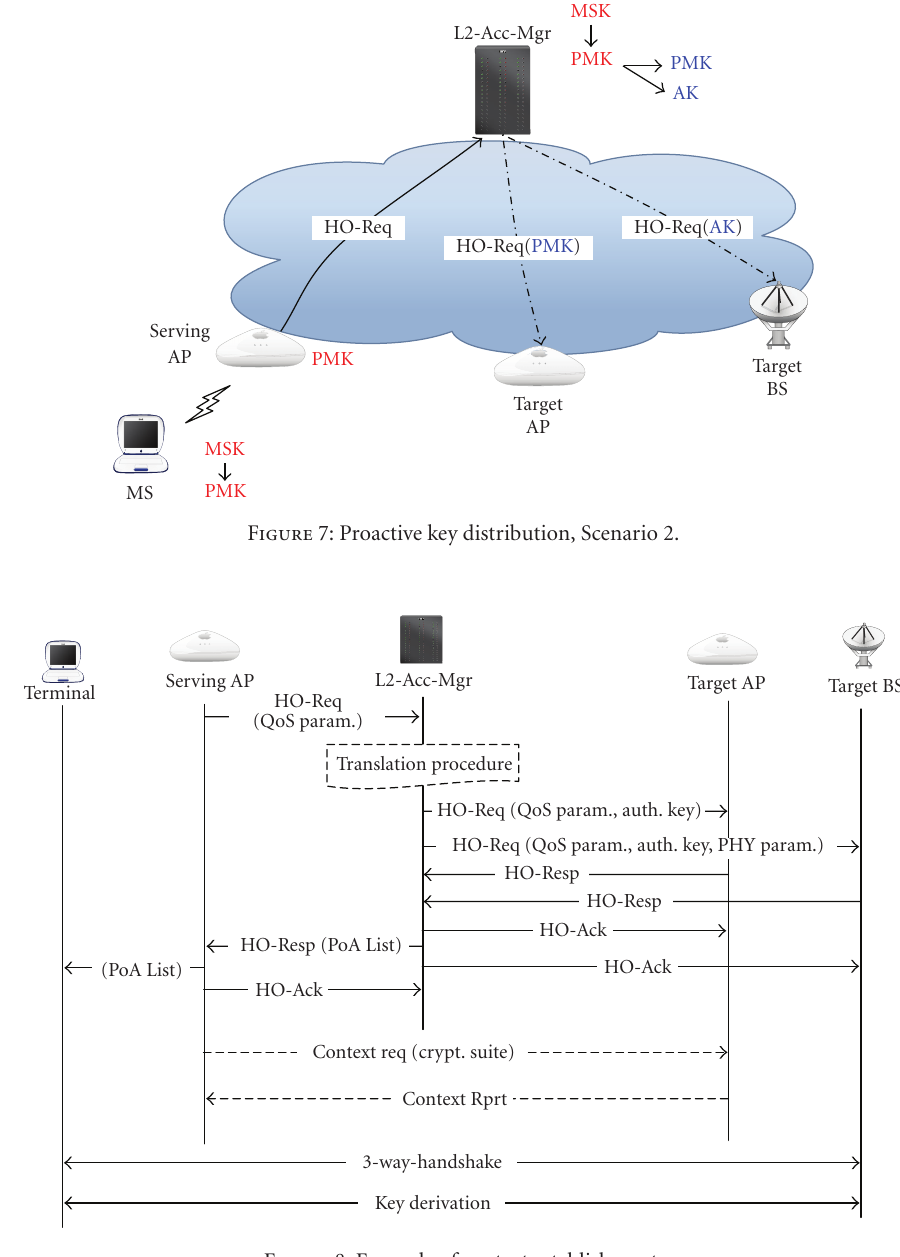
Figure 8: Example of context